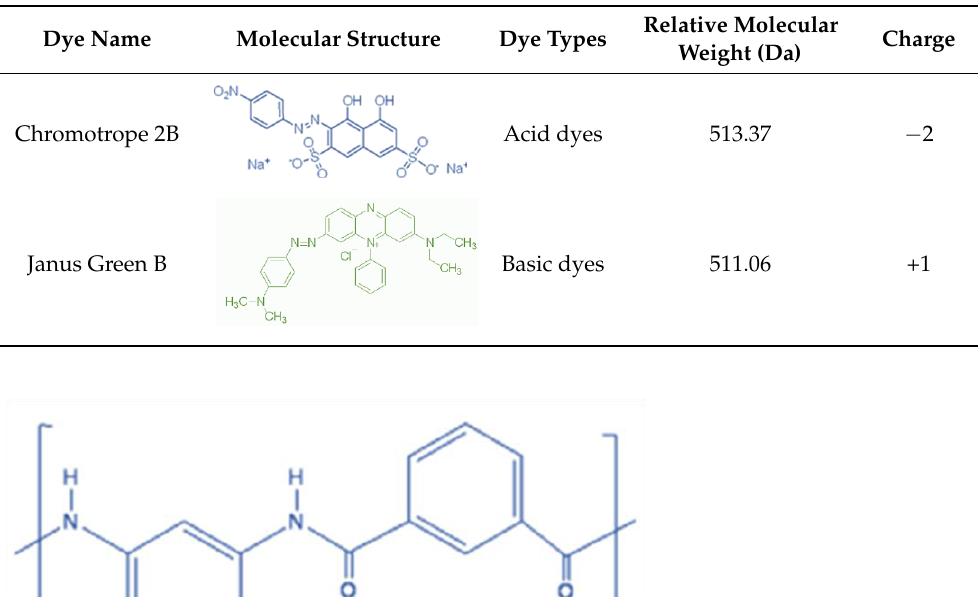
Figure 1. Chemical structure of PMIA. Table 1. Characteristics of the Chromotrope 2B and Janus Green B.